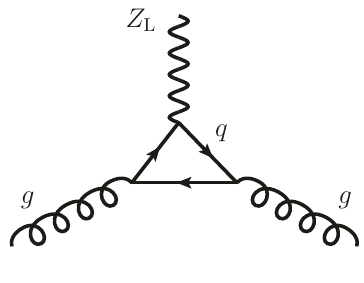
Figure 9 . Triangle diagram contributing to Z L → gg . Here, q is a generic quark, q = u, d, c, s, t, b . The final contribution comes from adding to this diagram the analogous one with the quark momenta in the loop